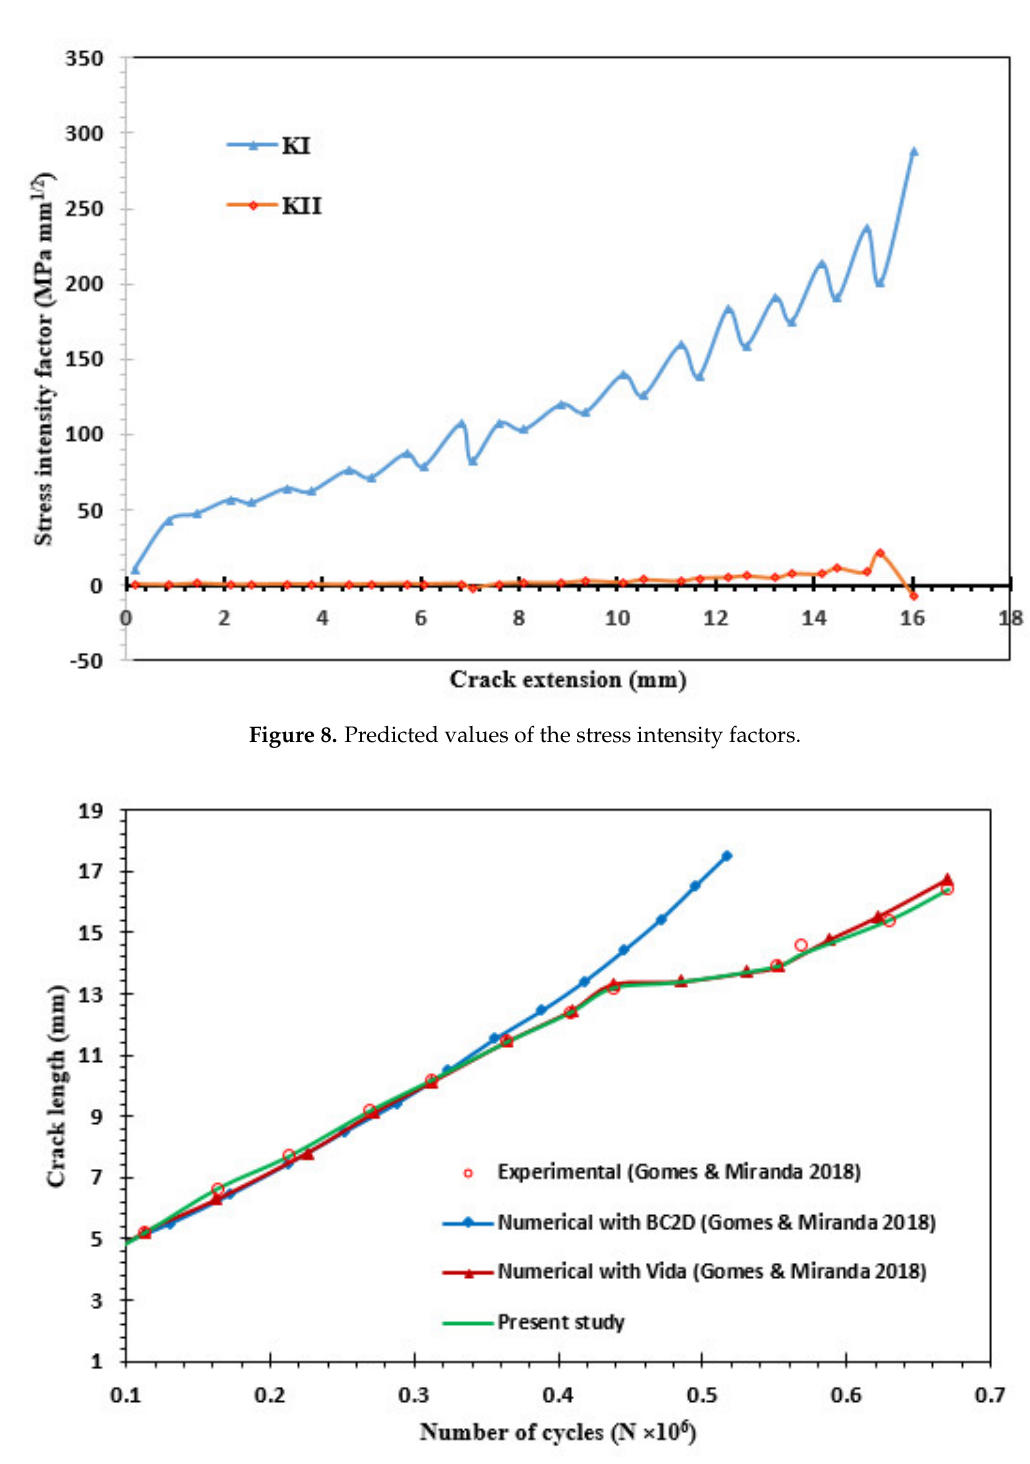
Figure 9. Comparison for fatigue life of the modified four-point bending beam.